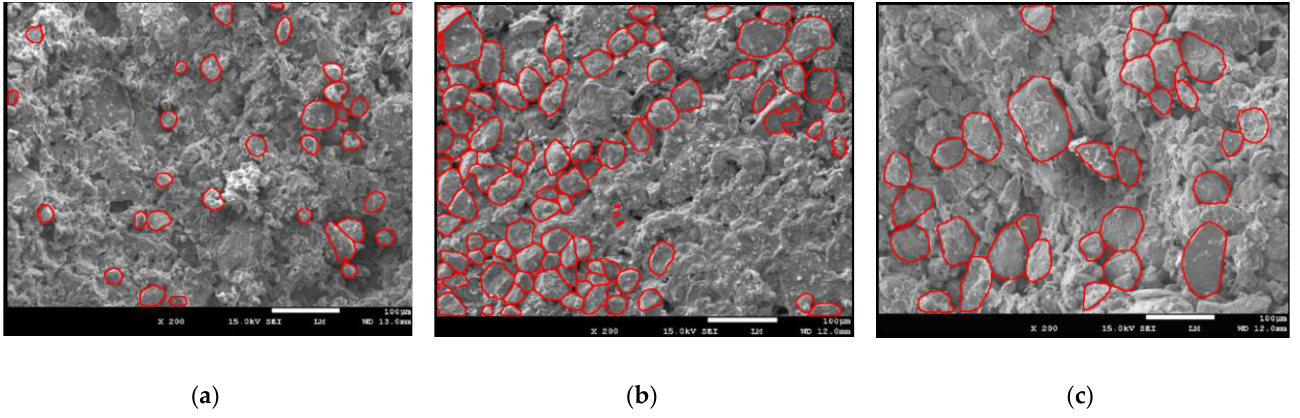
Figure 8. SEM pictures of XG-silt at ×200 magnification: ( a ) m bp / m s = 0%; ( b ) m bp / m s = 1.0%; ( c ) m bp / m s = 2.0%.